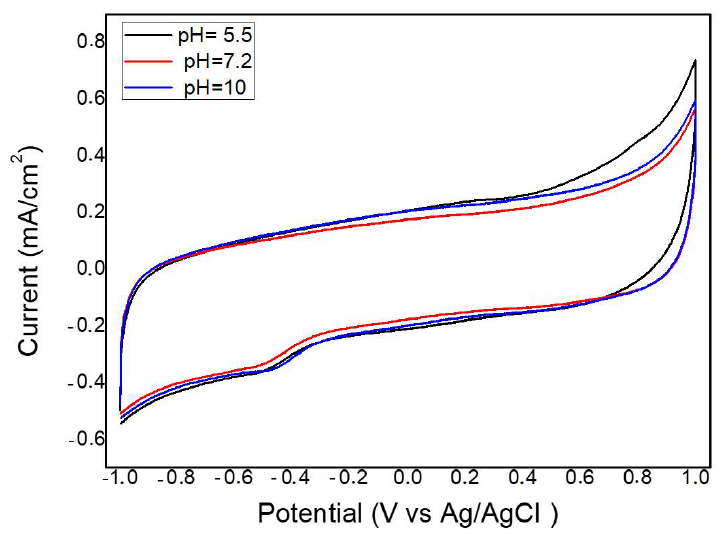
Figure 5. Cyclic voltammetry (CV) curves obtained with 3 different pH in Mo/CNT studies.